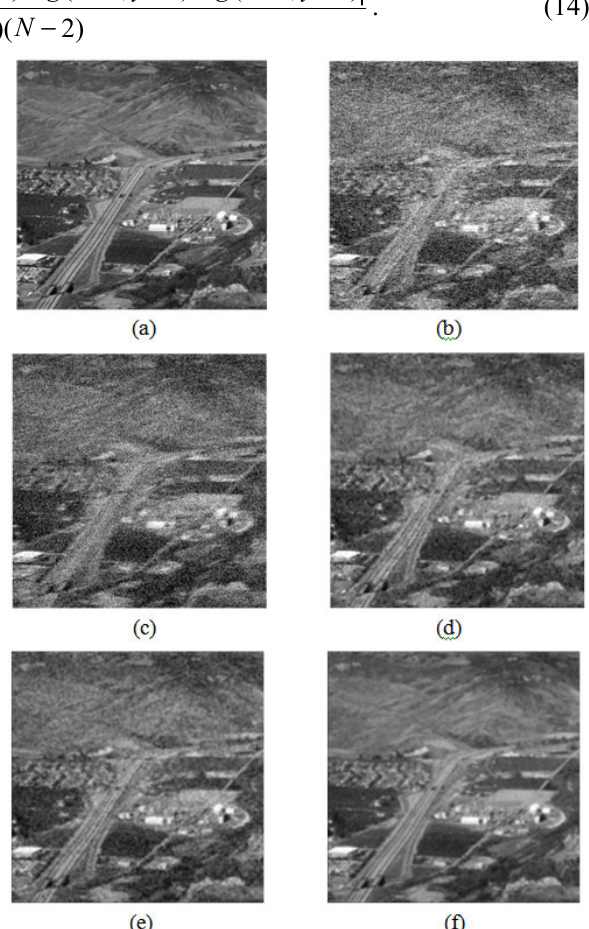
Fig. 1 Original image, simulated degradation images and the restored results: (a) original chemical plant image, (b) degraded chemical plant image 1, (c) degraded chemical plant image 2, (d) restored image by the Wiener-IBD algorithm, (e) restored image by the RL-IBD algorithm, and (f) restored image by our